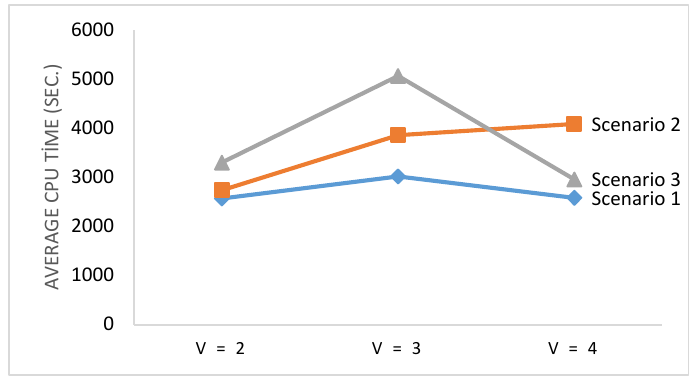
Fig. 8. Effect of 𝑉 on the average CPU timefor 𝑇 = 5 (MILP-D